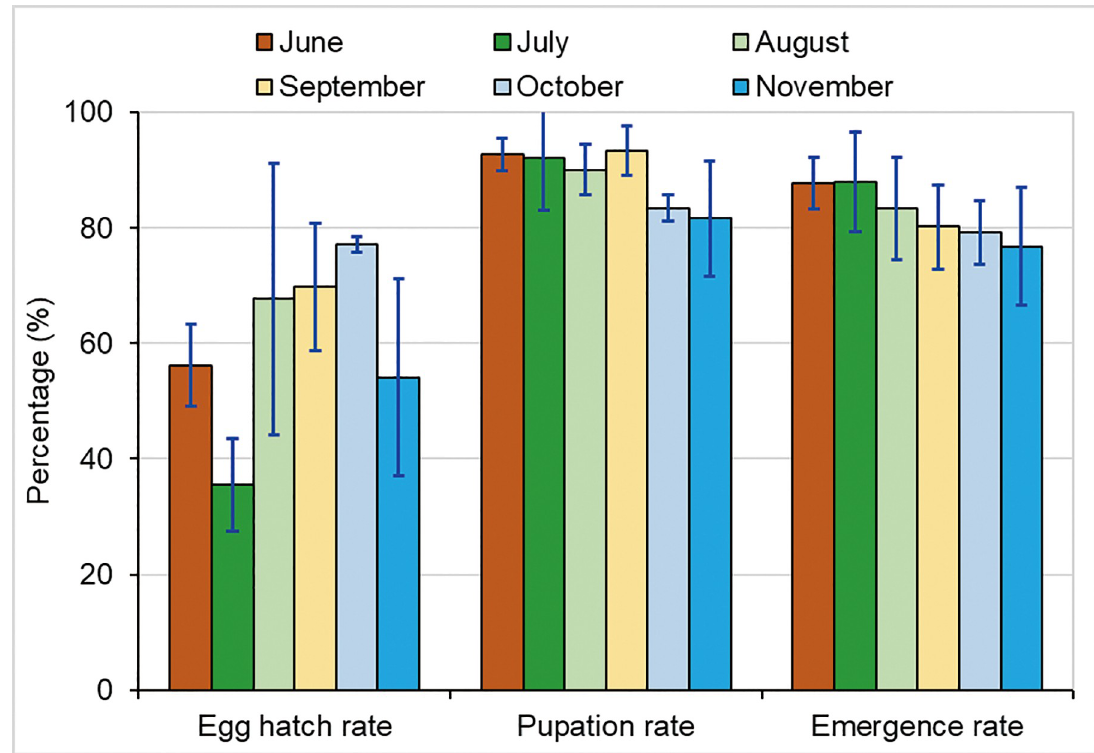
Fig 5. Egg hatch rate, pupation rate, and adult emergence rate of Ae . albopictus in each month. June-July experiments were conducted in semi-natural condition and August-November experiments were conducted in semi-field condition.